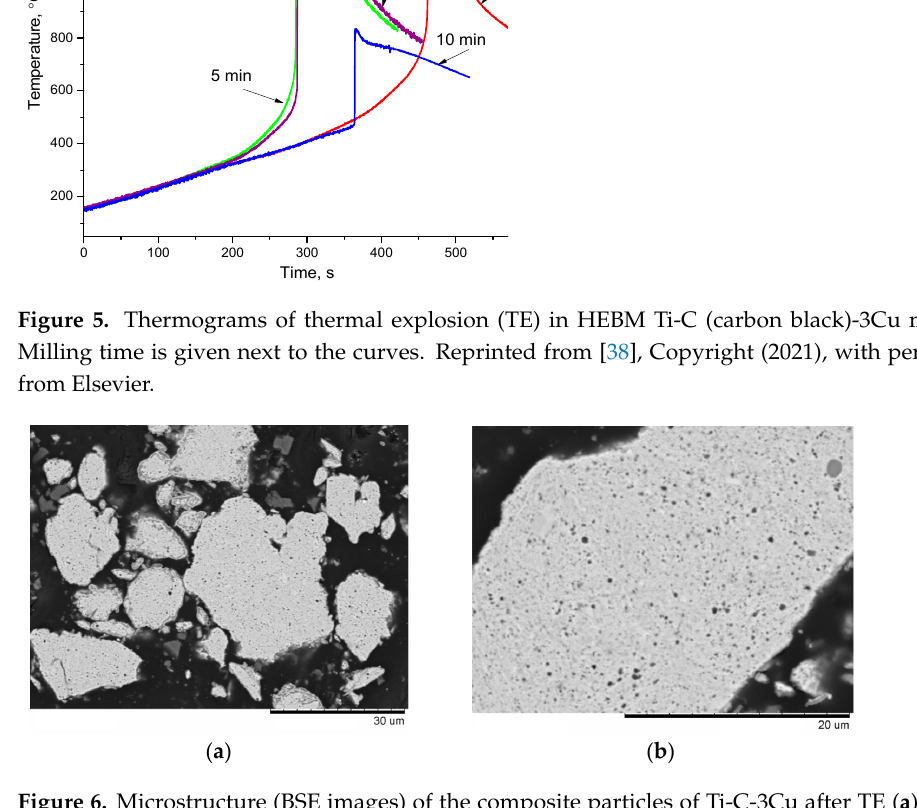
Figure 6. Microstructure (BSE images) of the composite particles of Ti-C-3Cu after TE ( a ), 10 min of HEBM ( b ), different magnifications. Reprinted from [38], Copyright (2021), with permission from Elsevier.